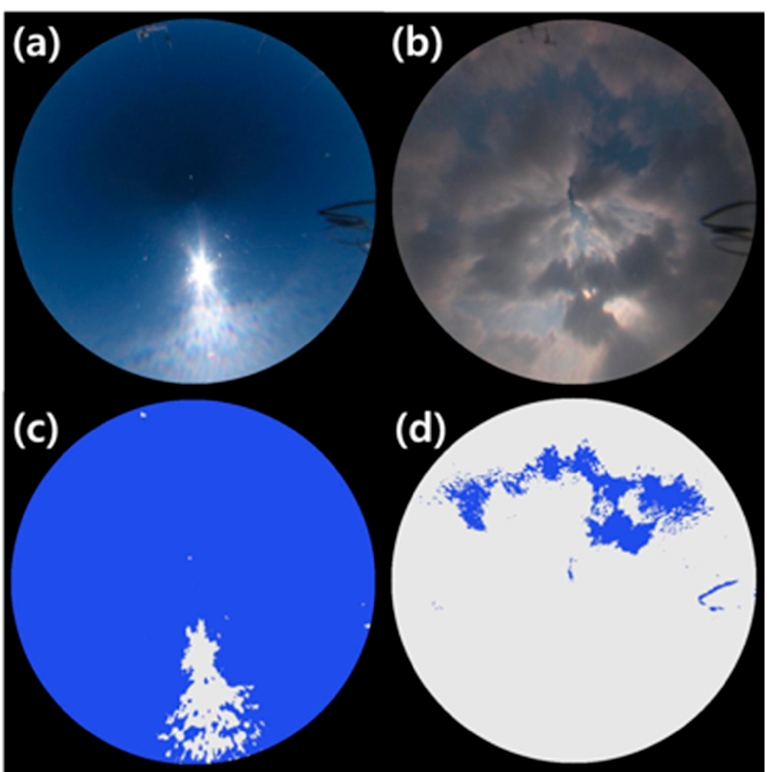
Figure 4. Sky images for ( a ) clear sky and ( b ) cloudy sky, and sky view cloudiness for ( c ) clear sky and ( d ) cloudy sky, at the Korea Institute of Energy Research (KIER ) observation station.